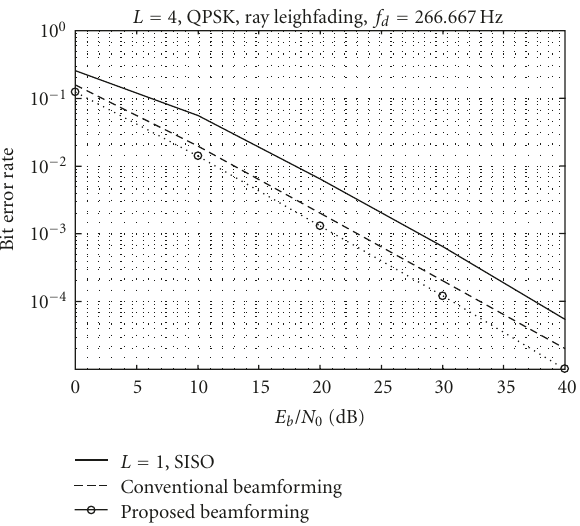
Figure 4: Performance comparison of the proposed beamforming scheme to the conventional